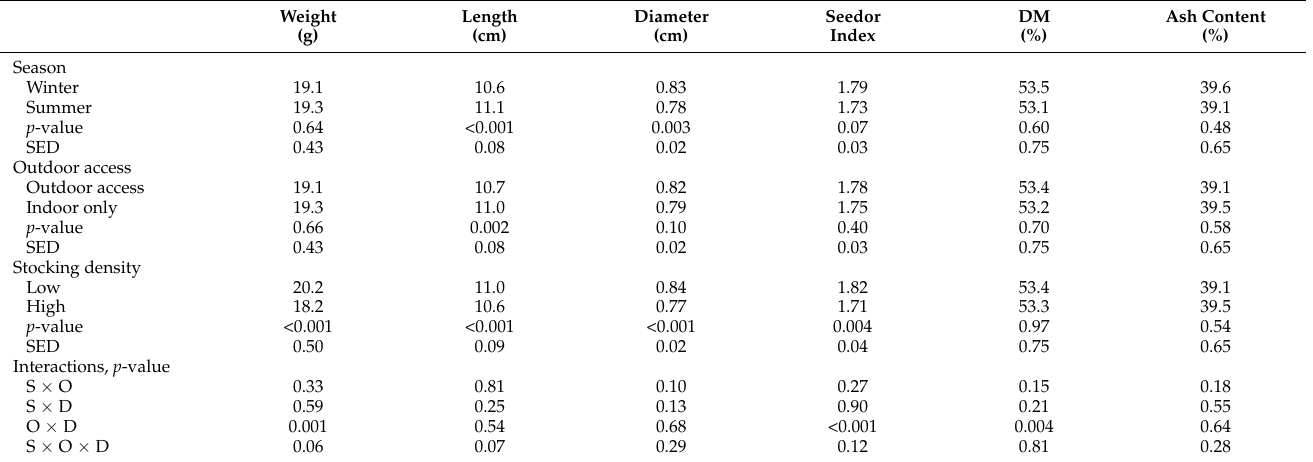
Table 11. Effects of season, outdoor access, and stocking density on the tibia bone properties of Cobb500